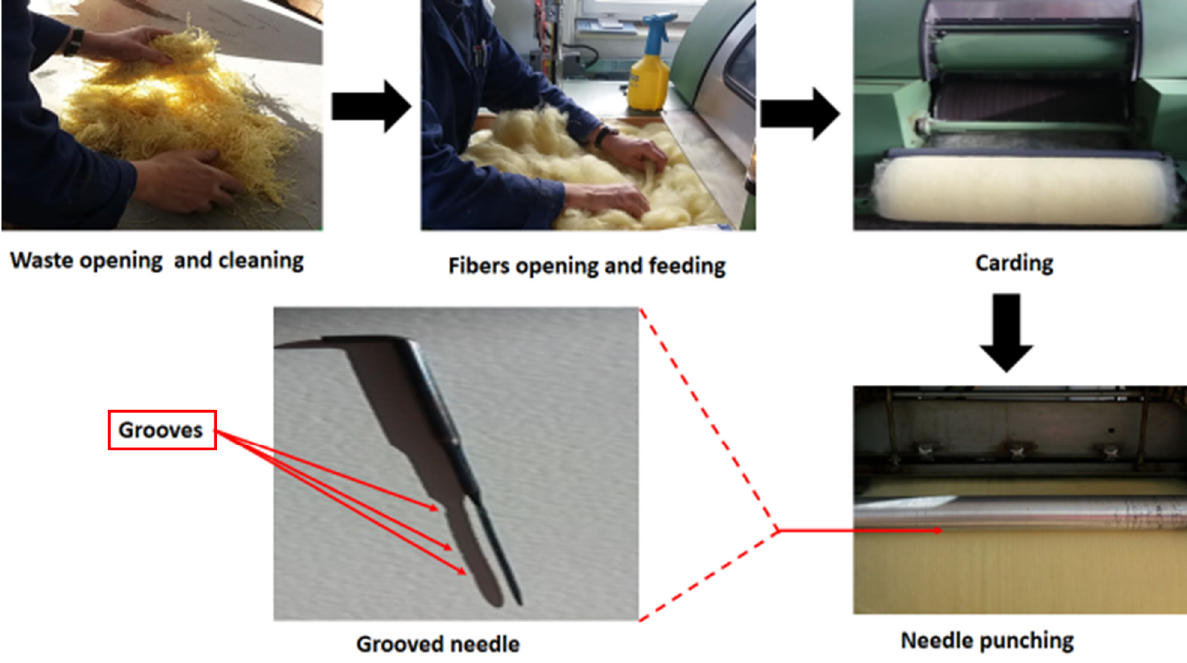
Figure 1. Schematic diagrams to convert Kevlar waste into a nonwoven web.